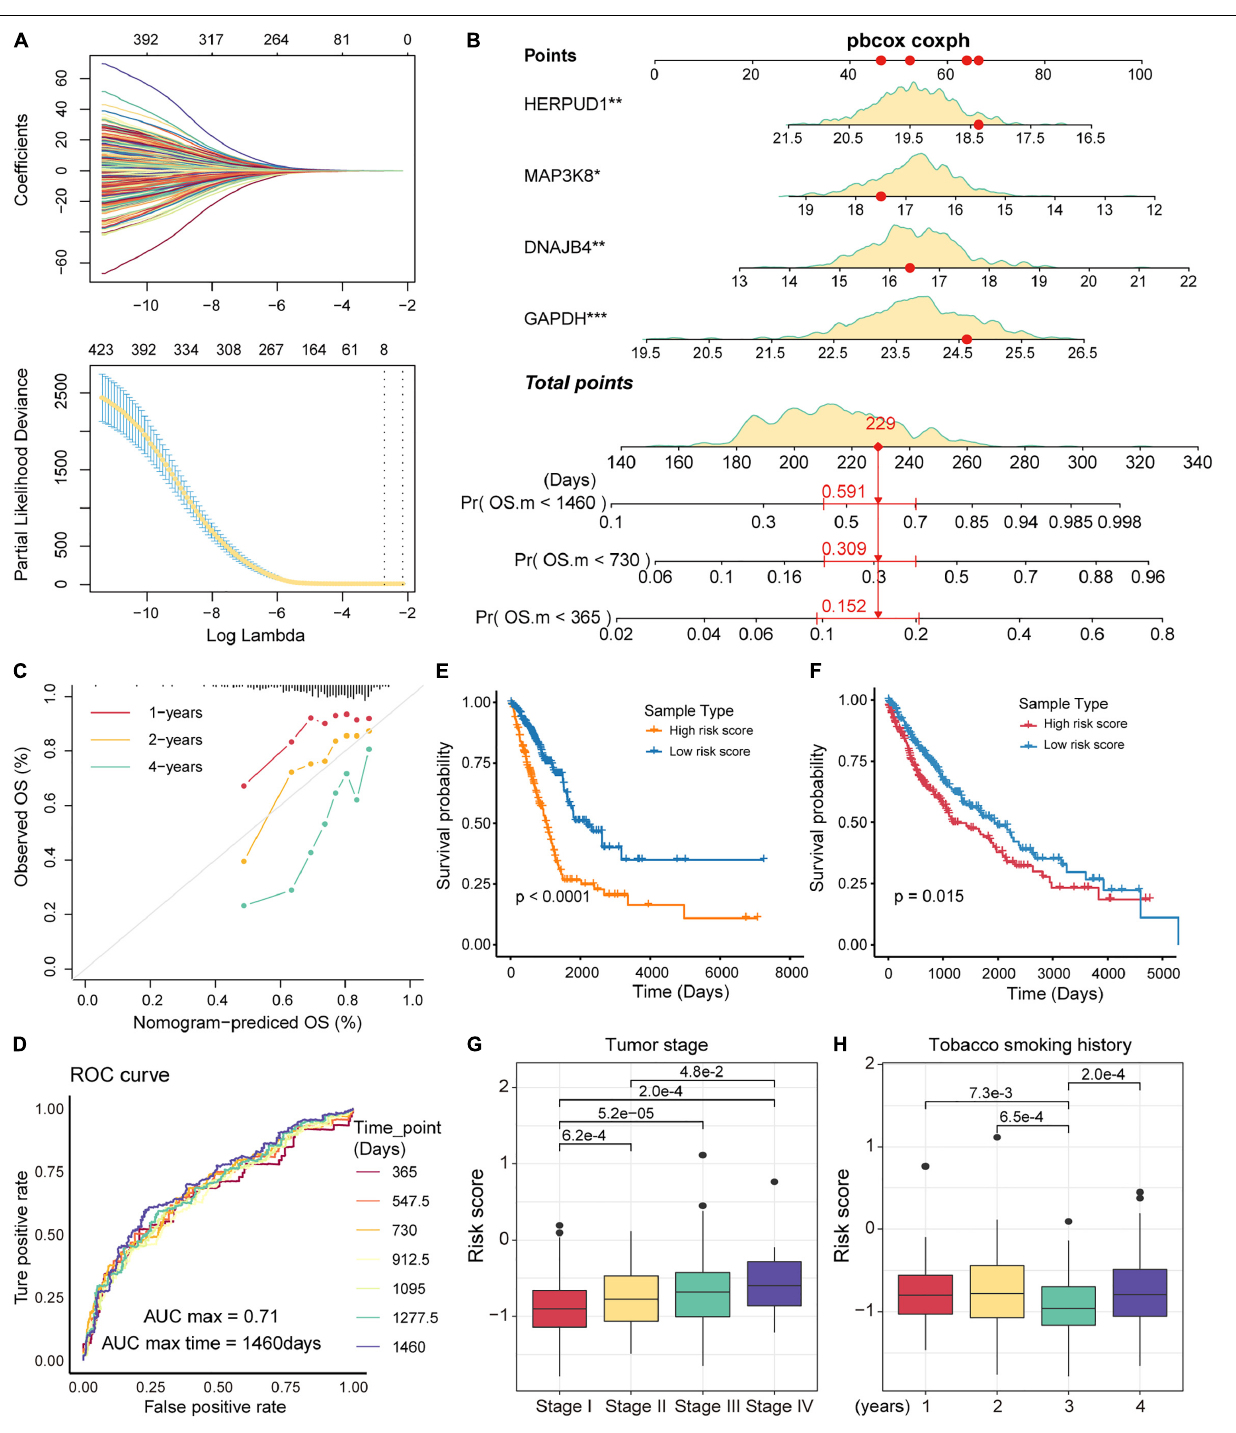
Frontiers in Cell and Developmental Biology |